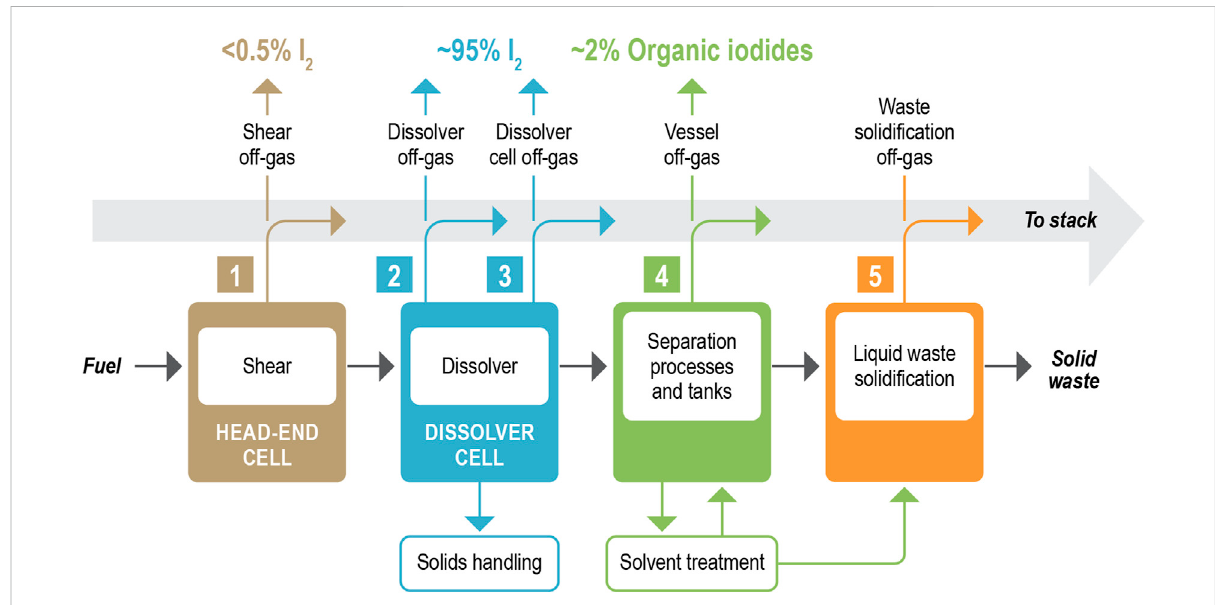
FIGURE 1 Schematic of iodine partitioning during aqueous reprocessing of used nuclear